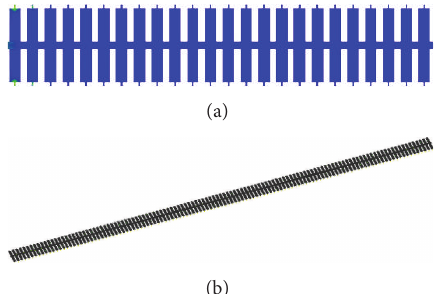
Figure 3: 1D 24-element array (a) and 120-element array (b).